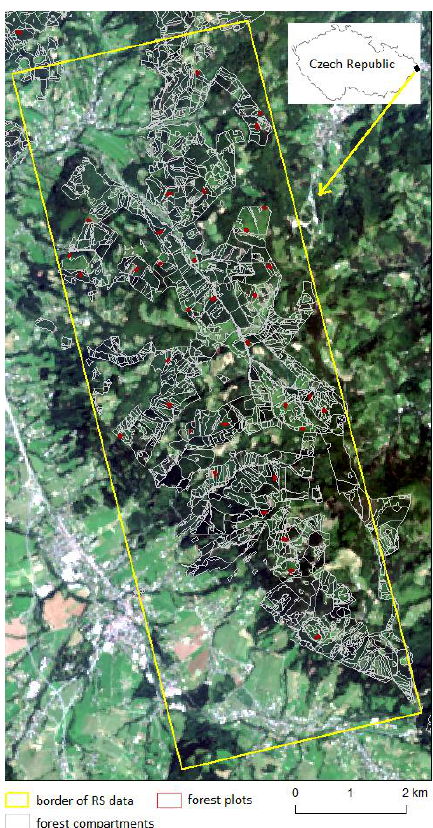
Figure 1. Location of study area. Spatial extent of remote